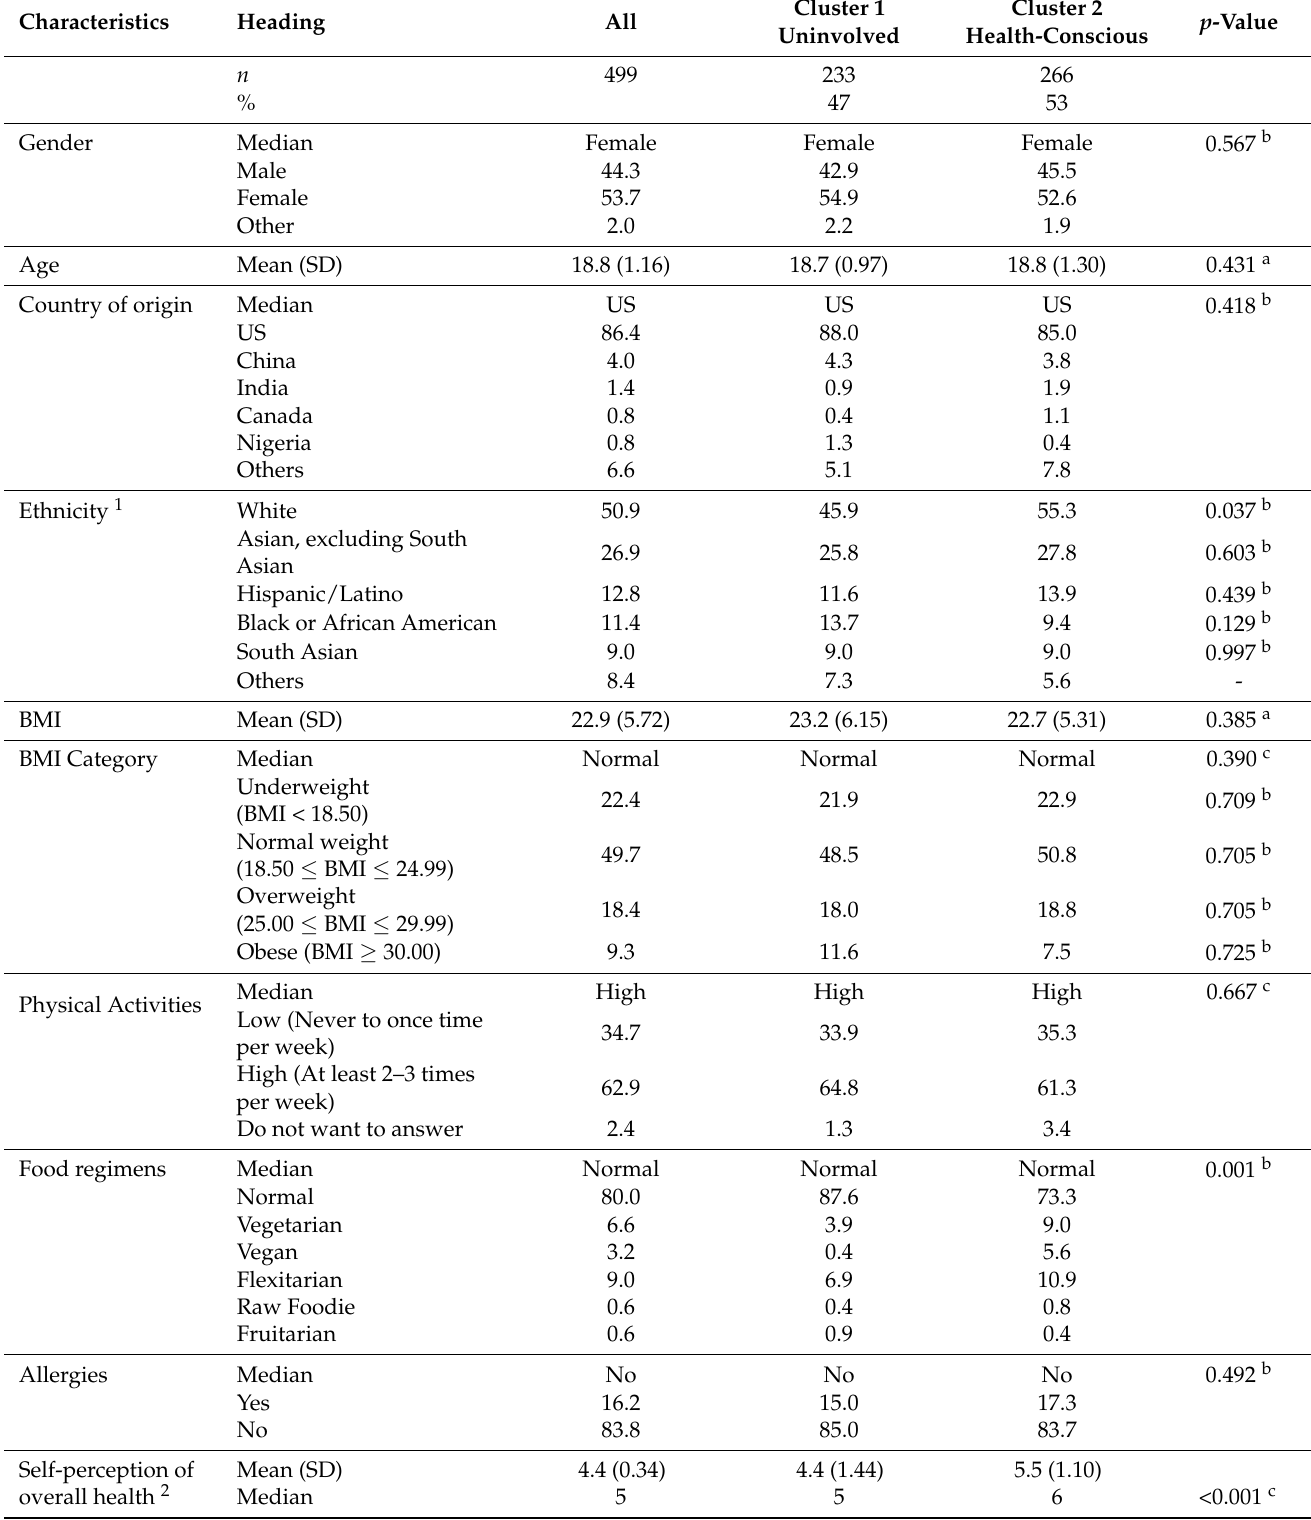
Table 1. Socio-demographic and anthropometric (%) characteristics of the total sample, Cluster 1 and Cluster 2.